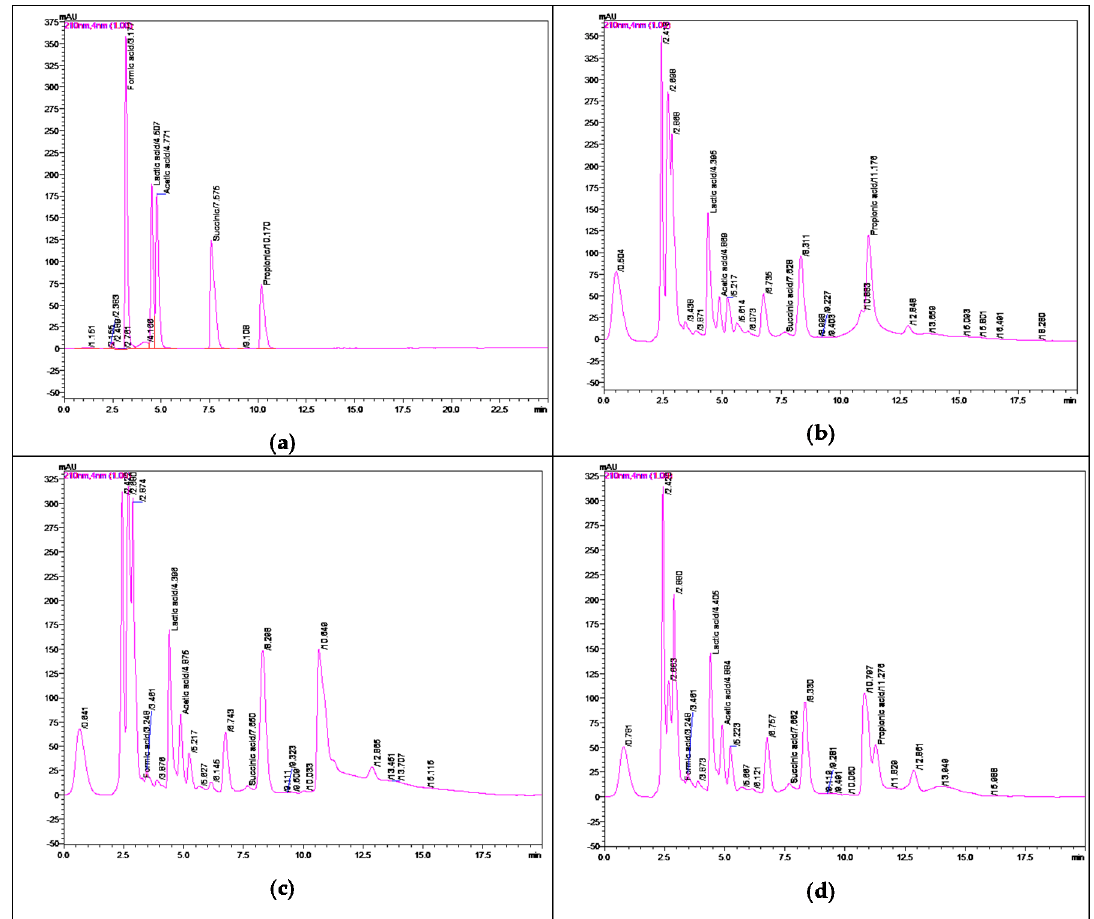
Figure 1. Examples of RP-HPLC-DAD chromatograms of the standards ( a ) of organic acids and organic acids extracted from 3-week silage product samples of ( b ) gibel carp ( Caracius gibelio ), ( c ) klunzinger’s ponyfish ( Equulites klunzingeri ), and ( d ) by-products supplied by a local fish processing company. The chromatographic system and conditions were described above. The elution program for the separation and the calibration curves for quantification of acetic, formic, lactic, propionic and succinic acids were presented in the Table 2; Table 3, respectively.